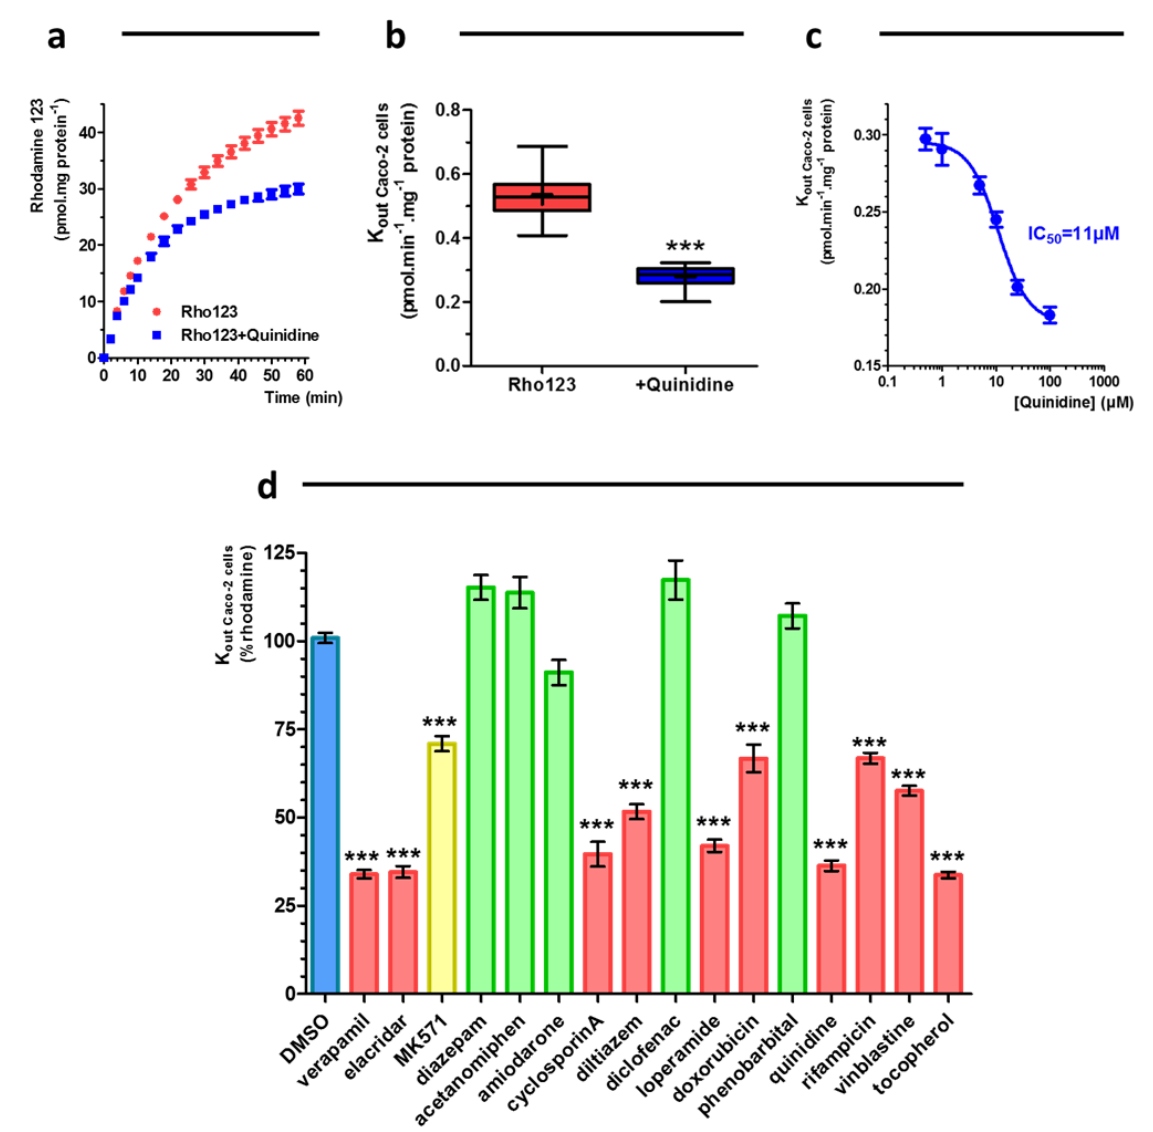
Figure 4. ( a ) Excretion of rhodamine 123 after incubation of cell Caco-2 monolayers in absence or in presence of 100 µM quinidine (mean ± s.e.m., n = 12). ( b ) Rate of excretion of rhodamine 123 after an incubation of cell Caco-2 monolayers in absence or in presence of 100 µM quinidine (box-and-whisker diagram, whiskers: min to max, mean: cross, n = 12, *** p < 0.001). ( c ) Concentration-dependent effects of quinidine on R123 excretion from Caco-2 cells (mean ± s.e.m., n = 12). ( d ) Effect of drugs on Rate of excretion of rhodamine 123 (mean ± s.e.m n = 12–66, *** p < 0.001).